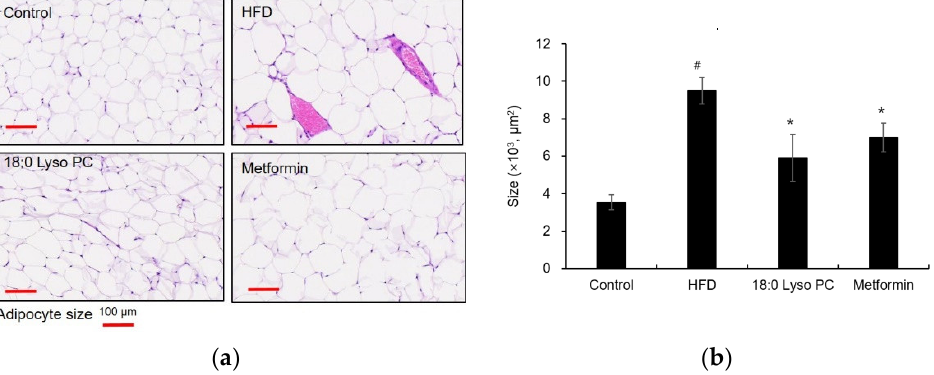
Figure 3. Histological analysis of gonadal adipose tissue in high-fat diet-fed mice. ( a ) Hematoxylin and eosin-stained images for adipocyte area from different groups (scale bar, 100 µ m), ( b ) the distribution of adipocyte area in adipose tissue ( µ m 2 ). The results are presented as mean ± SD ( n = 6). Significant differences were identified at # p < 0.005, the control group vs. the high-fat diet (HFD) group; * p < 0.005, the HFD group vs. the treatment group.